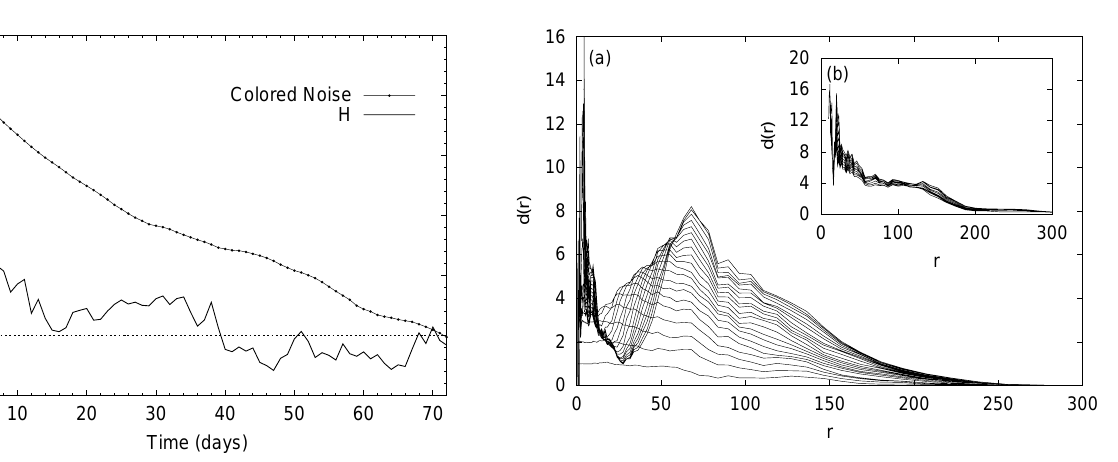
Fig. 7. The autocorrelation coefficient of the time series of H and that of the coloured noise with the same correlation dimension D = 3 . 7 .